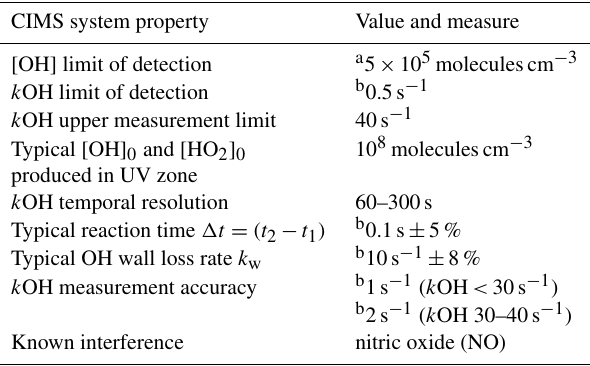
Table 1. MOHp CIMS k OH measurement and system properties.